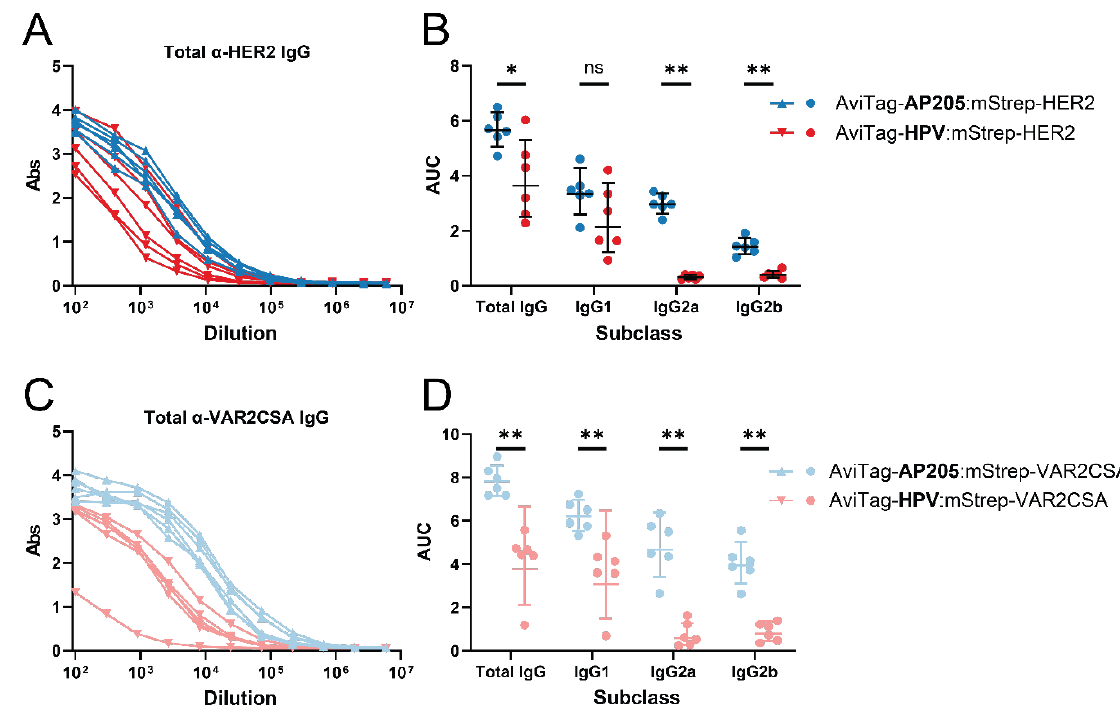
Figure 3. Effect of the cVLP backbone on IgG profile. Mice ( n = 6) were immunized with antigen coupled to either HPV or AP205 through the non-covalent AviTag:mStrep interaction. The doses of HER2 and VAR2CSA were 2 µg and 1.19 µg antigen respectively. Antigen specific antibodies were quantified by ELISA. ( A ) Total anti-HER2 IgG dilution curves and ( B ) Area under the curve (AUC) for Total IgG, IgG1, IgG2a and IgG2b. ( C ) Total anti-VAR2CSA IgG dilution curves and ( D ) AUC for total IgG, IgG1, IgG2a and IgG2b. Each dot represents one animal. Full dilution curves are available in Supplementary Figure S2. Not significant (ns) p > 0.5; * p ≤ 0.5; ** p < 0.01.